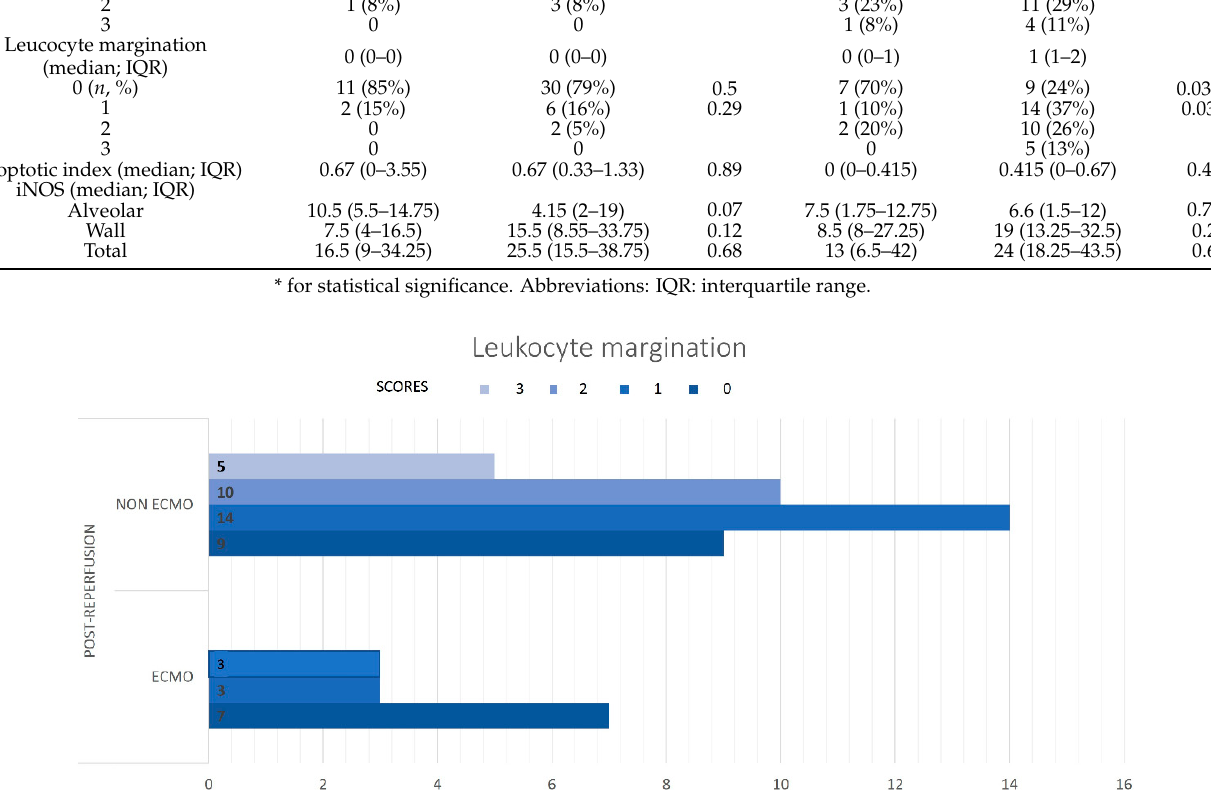
Figure 4. Real-time PCR for iNOS expression performed in 12 cases (6 ECMO and 6 non-ECMO patients post-reperfusion). Fold changes between ECMO and non-ECMO patients post-reperfusion showed higher median Δ Ct values in the non ECMO group in comparison to the ECMO group, even if not significant. Data are expressed as 2-° ∆ Ct values (the value was assumed to be 1 for the ECMO group).